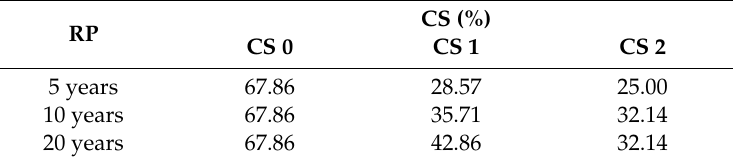
Table 7. Conduit surcharge (CS) index for design storm events.